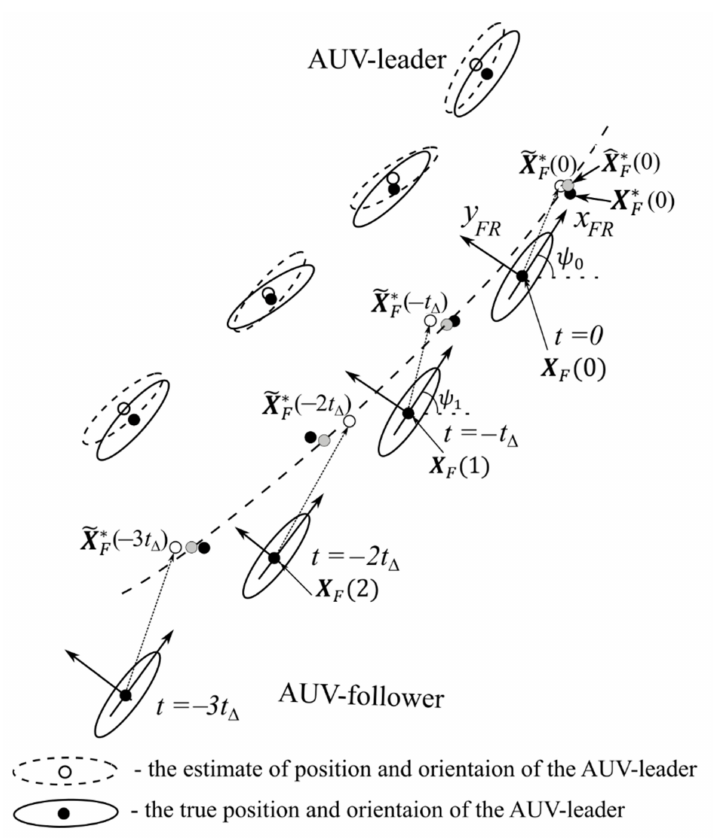
Figure 3. The measurement series for defining the position and parameters of movement of target